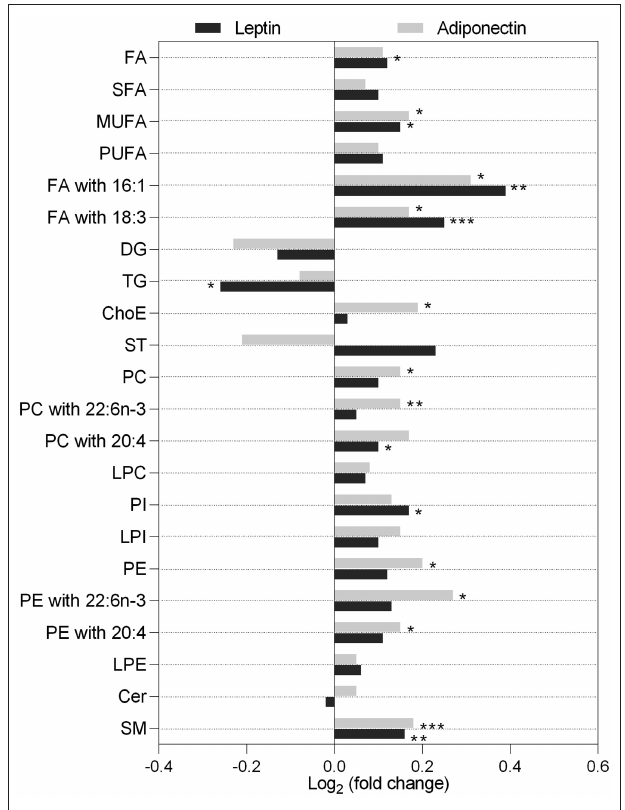
FIGURE 2 | Serum lipidomic signatures associated with higher circulating levels of leptin (dark gray) and adiponectin (light gray). Data presented as log 2 of the lipid level fold change between patients with hormone levels higher than the median vs. lower than the median. Leptin median level = 39.61ng/ml; higher, n = 99; lower, n = 99. Adiponectin median level = 4.84 µ g/ml; higher, n = 95; lower, n = 99. Cer, ceramide; ChoE, cholesteryl ester; DG,